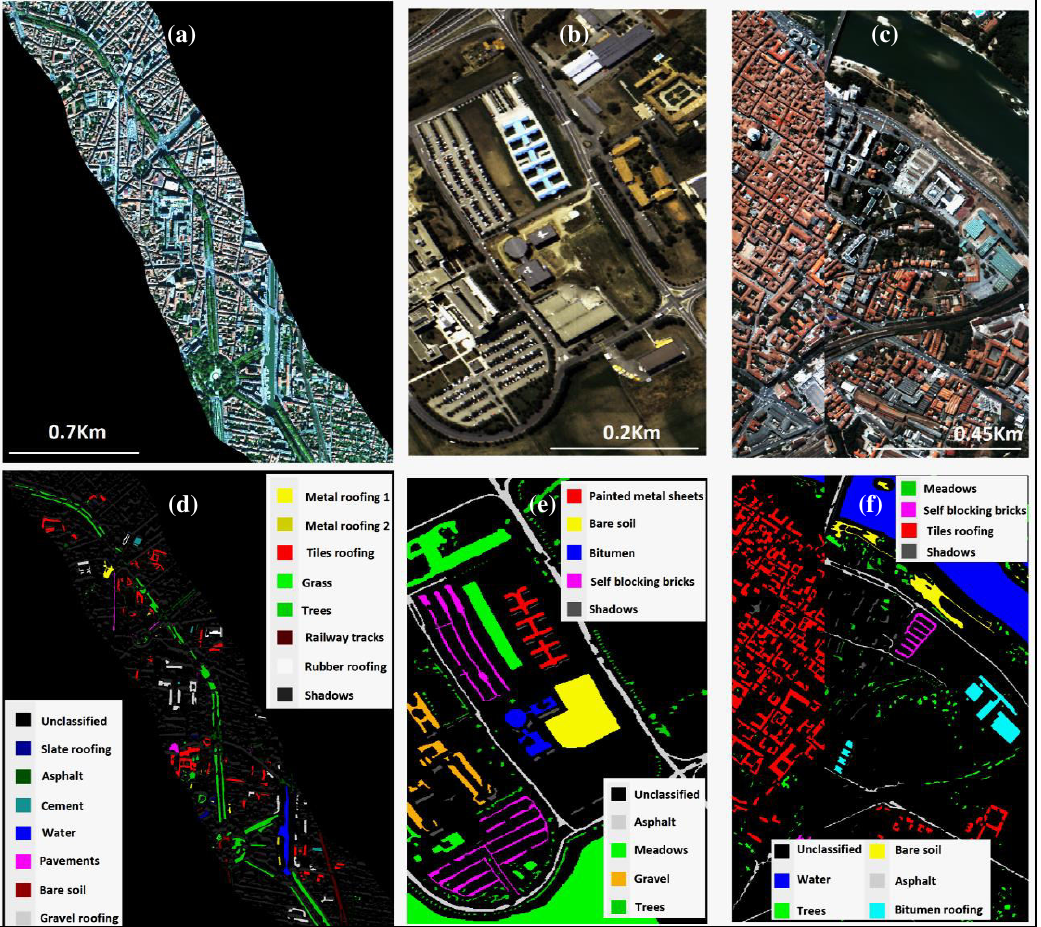
Figure 2. RGB Datasets and corresponding ground truth; (a),(d) Toulouse center, (b),(e) Pavia University, (c),(f) Pavia